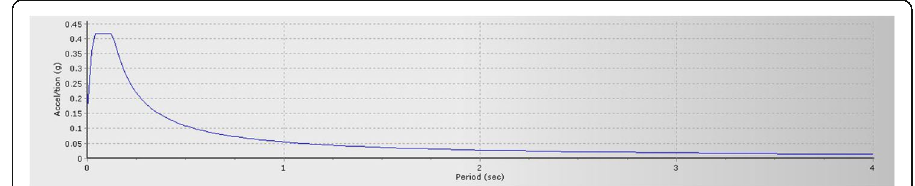
Fig. 11 Target response spectrum of soil class ( D ) and seismic design category ( C ), which generated according to ASCE